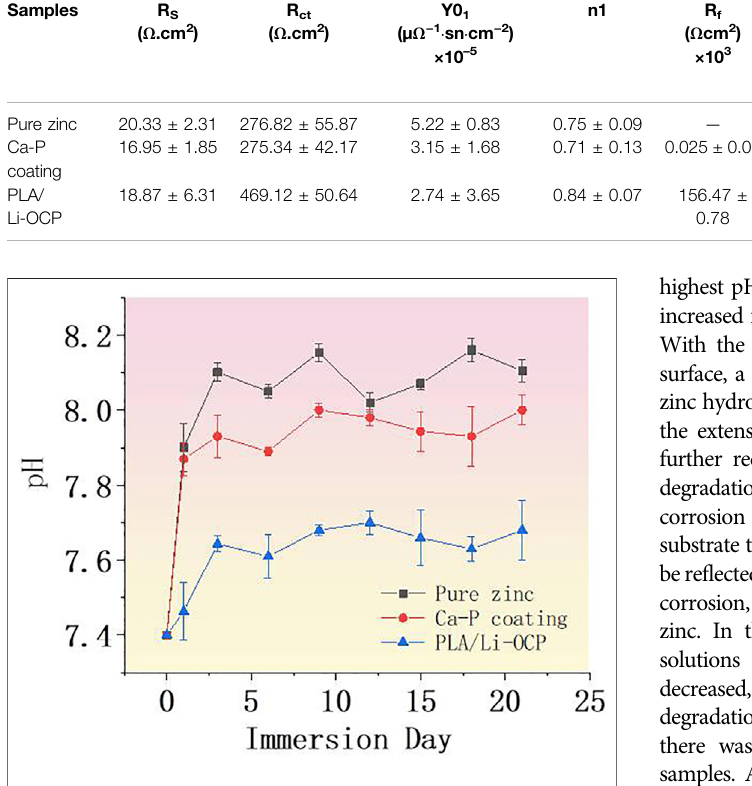
FIGURE 5 | The pH value of SBF solution immersed with